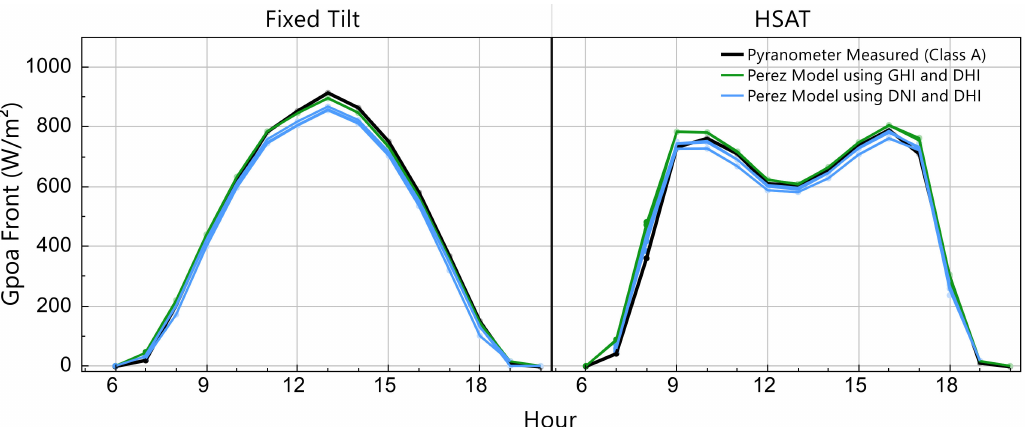
Figure 13. Overlay of simulated and measured frontside global POA irradiance on fixed-tilt and HSAT structures. The data shown are from a clear sky day (23 March 2020) and are grouped by which solar radiation data were used as input to the